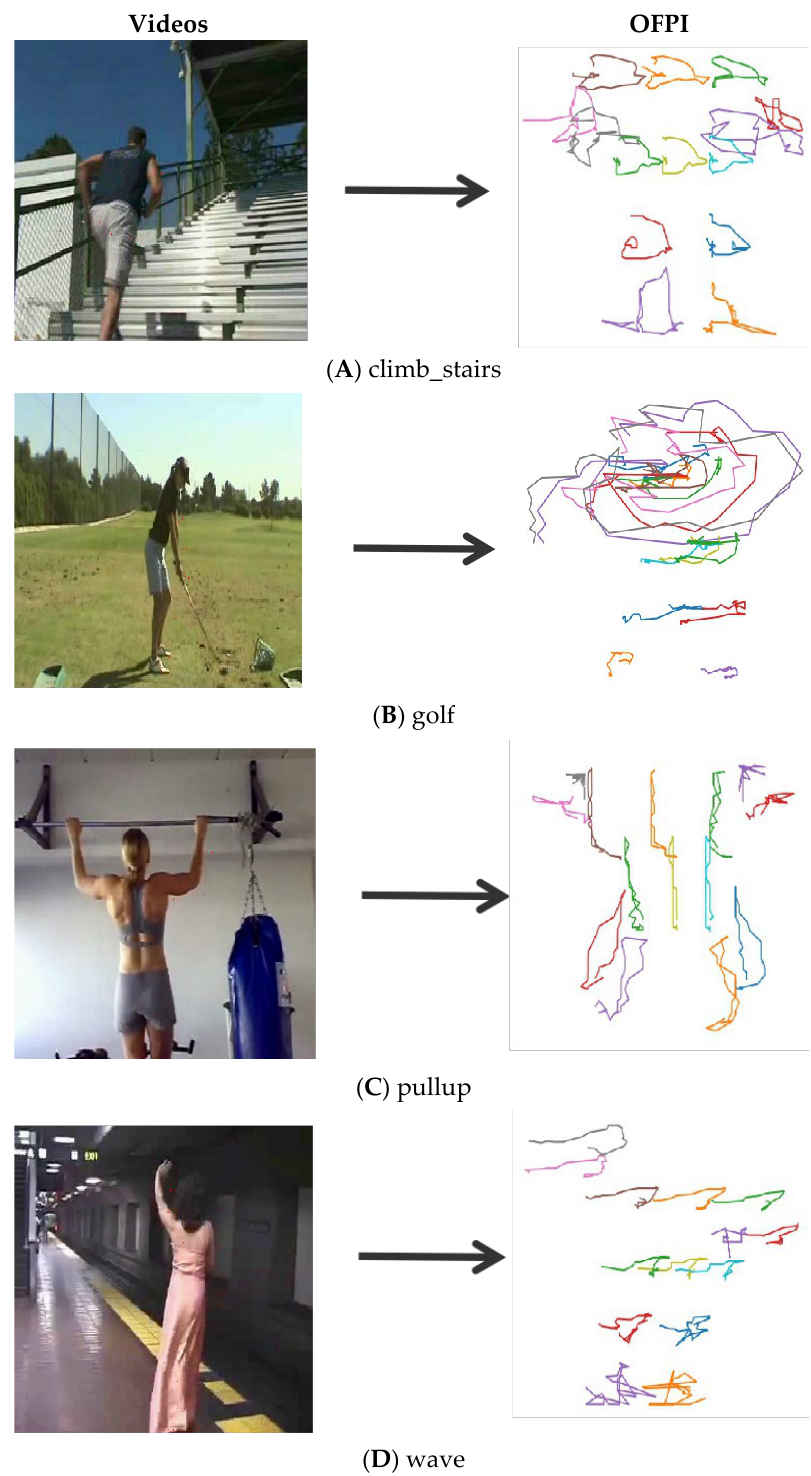
Figure 4. Listing of OFPI representations for different action categories. ( A ) climb_stairs, ( B ) golf, ( C ) pullup, and ( D ) wave.